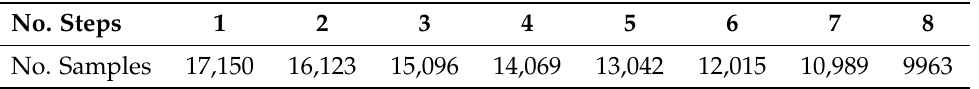
Table 1. Number of samples available according to the number of steps.